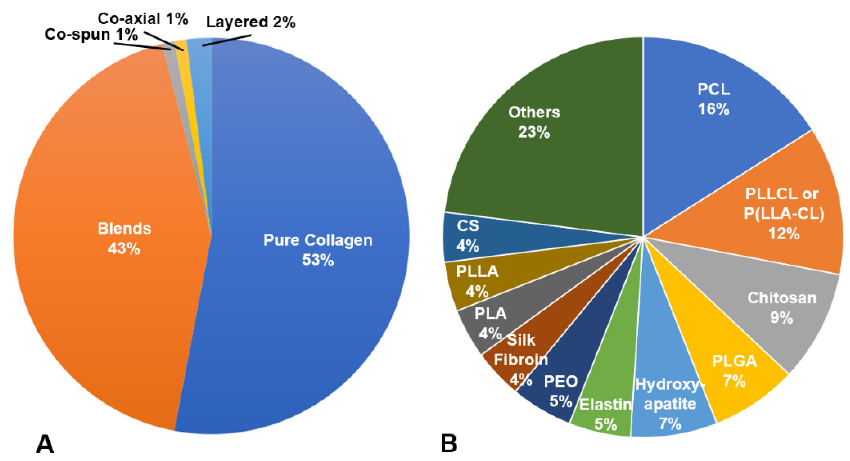
Figure 4. ( A ) Type of collagen-based electrospun scaffolds; ( B ) distribution of materials combined with collagen in electrospun scaffolds.